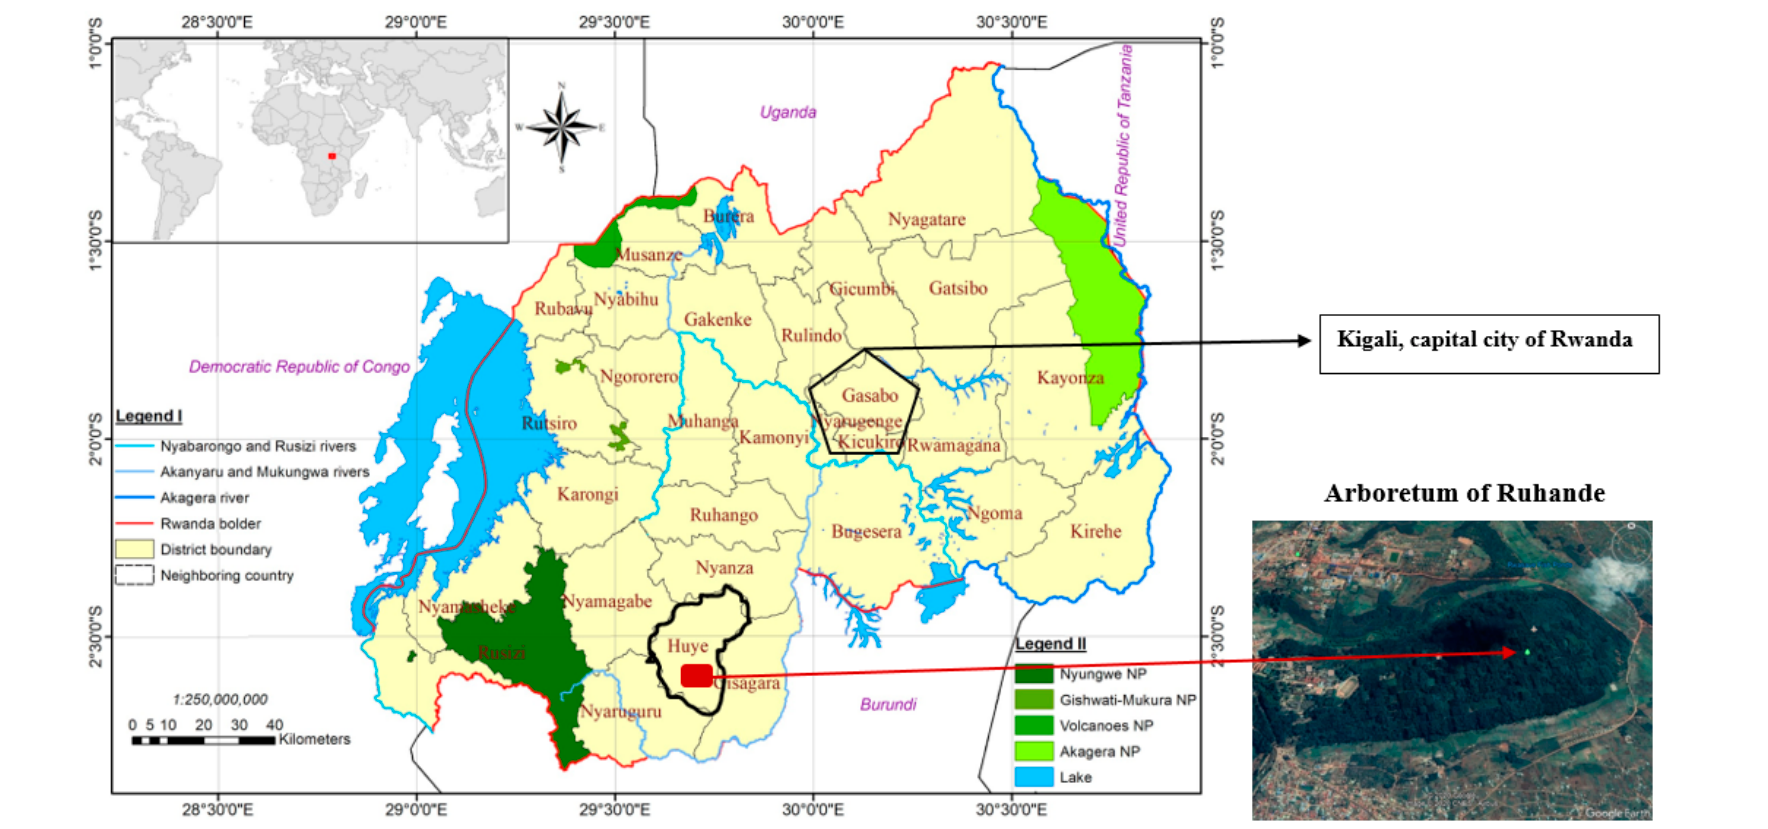
Figure 1. Geographical map of the study site.